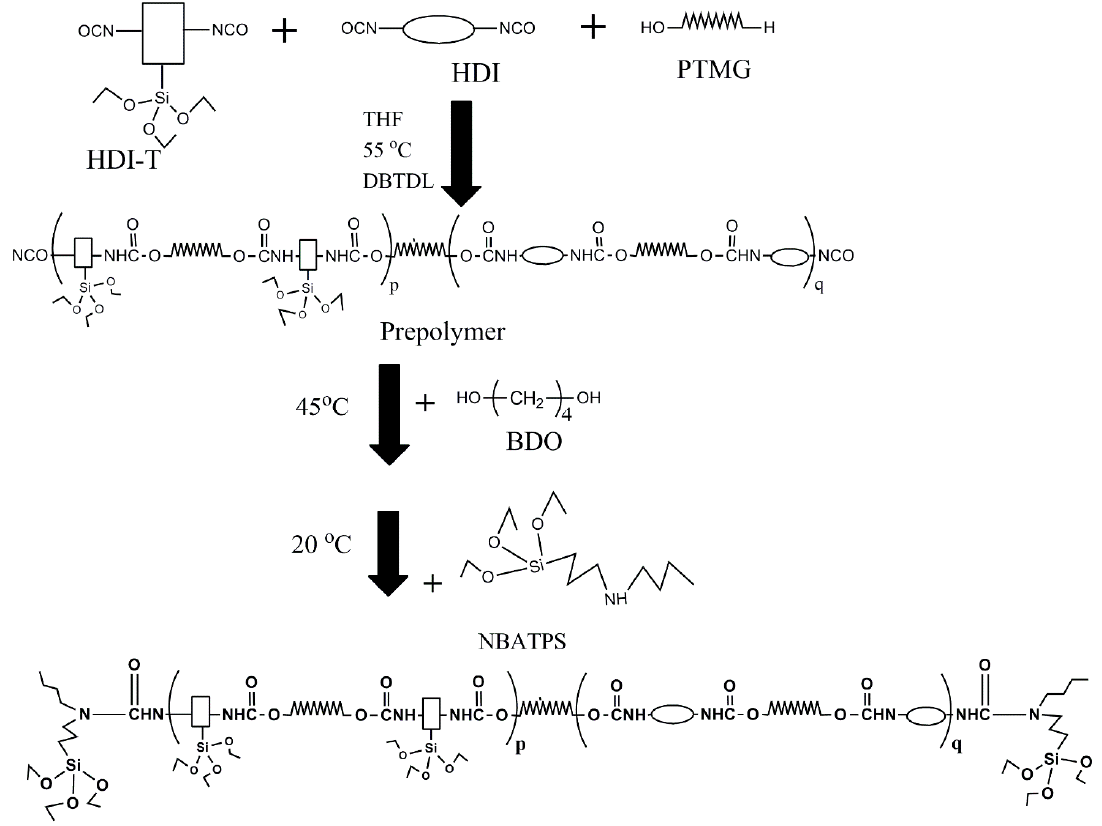
Figure 4. Preparation of SPU hybrids. Table 1. Compositions for the synthesis of SPU hybrids.